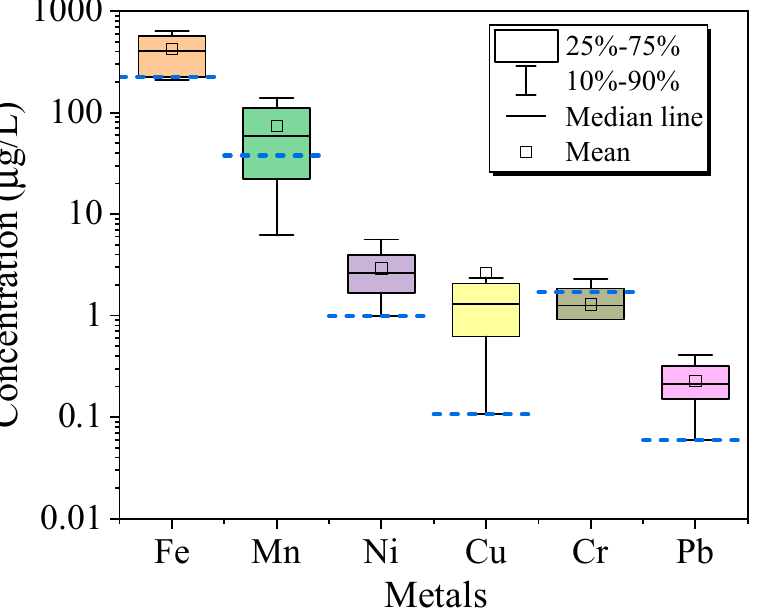
Figure 2. Variations in the concentrations of heavy metals ( µ g/L) in the urban streams. The blue dashed line refers to the reference level.